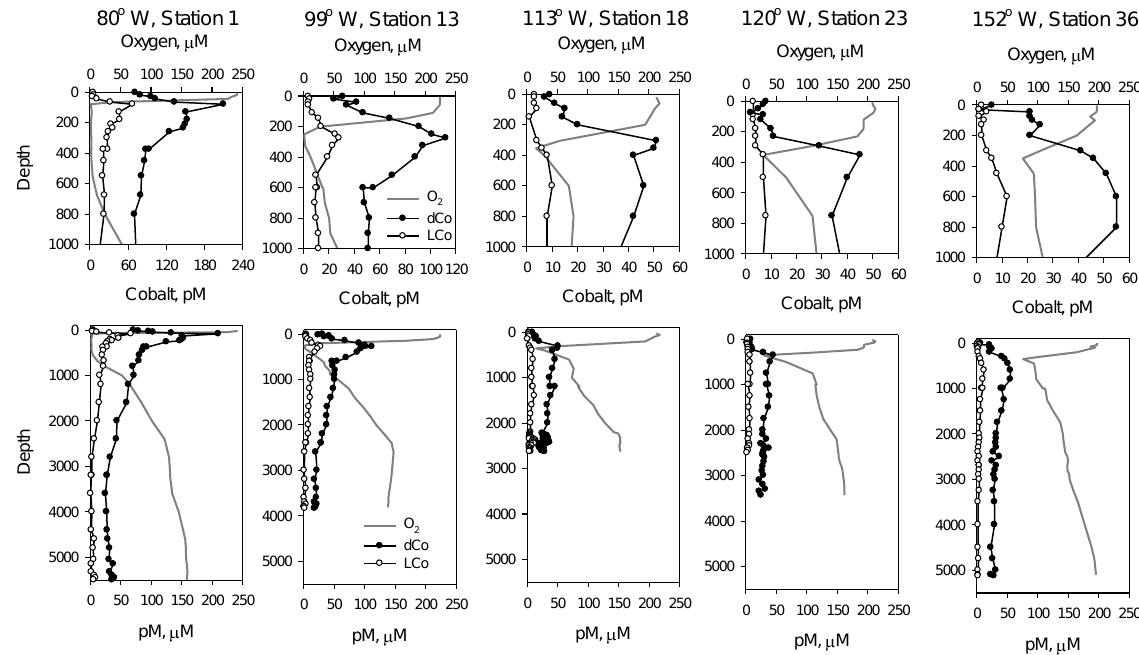
Figure 3. Profiles of dissolved cobalt (dCo, closed circles), labile dissolved cobalt (LCo, open circles), and O 2 (grey lines) across the South Pacific. Upper panels show a 0–1000m depth range; bottom panel show full profiles. dCo and LCo are highest close to the Peru margin (Station 1) and decrease westward. O 2 follows the opposite trend. The small peak at 2400m at Station 18 shows peak hydrothermal input from the East Pacific Rise. Note that the dCo and LCo scales in the upper panel are adjusted to highlight gradients and differ from the lower